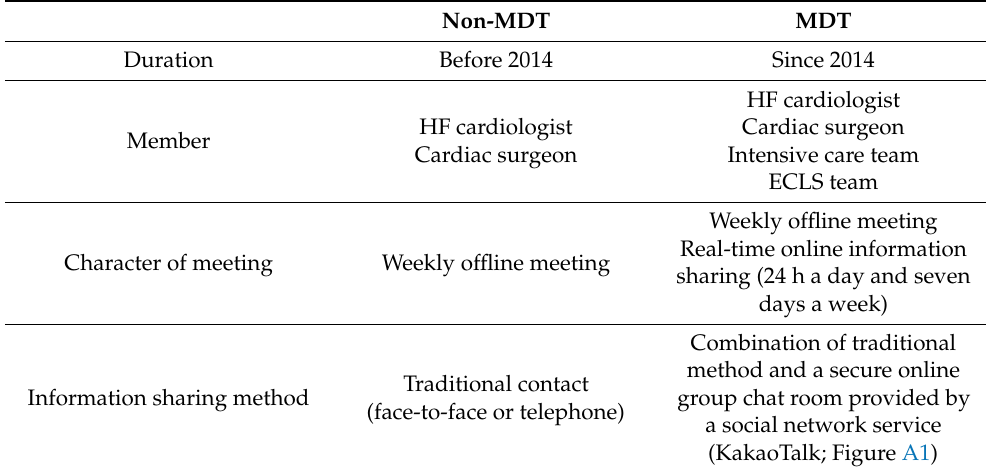
Table A1. Features of the multidisciplinary team compared with the non-multidisciplinary team.